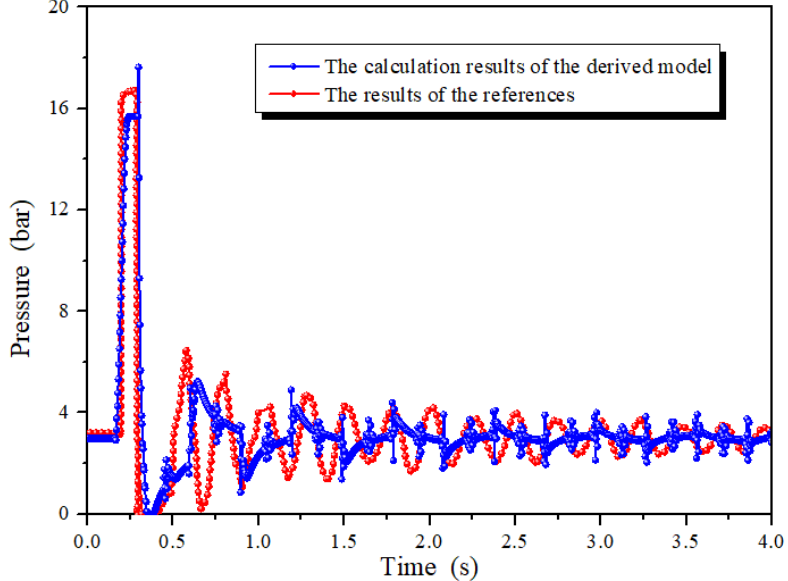
Figure 5. Comparison between calculation results of the present model and literature results.